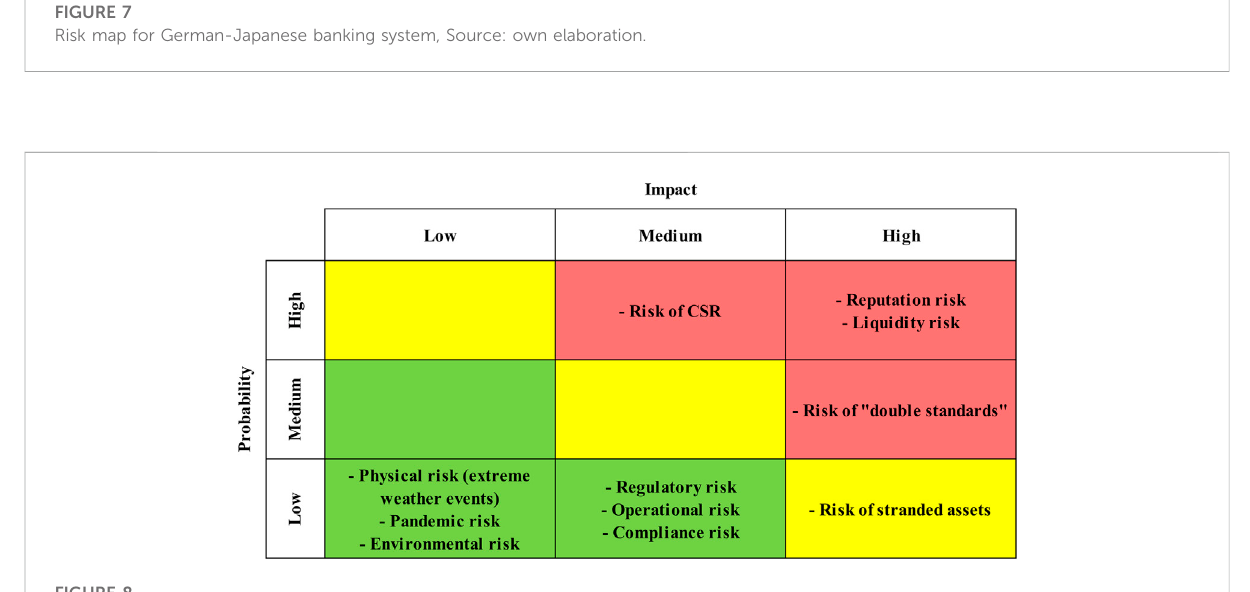
Risk map for Anglo-Saxon banking system, Source: own